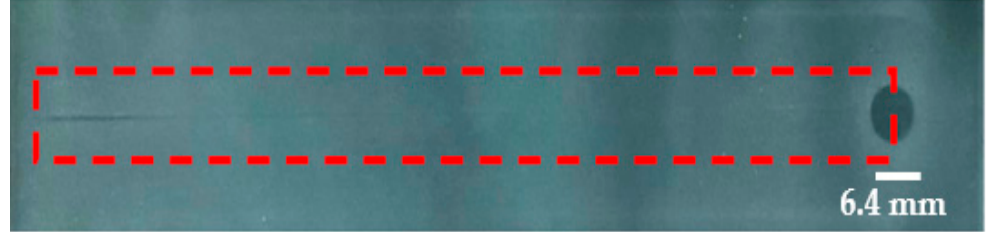
Figure 14. Tool 2 trial—X ‐ ray of an AA 6061 ‐ T6 aluminum FSW weld.